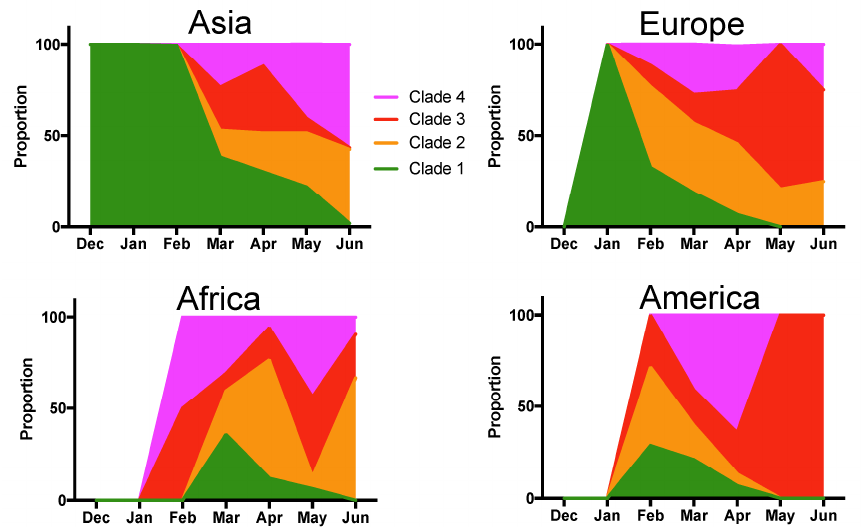
Figure 3. Temporal variations in Clade proportion per geographic region. Changes in the proportion of the indicated clades over time are shown for Asia, Europe, Africa and America.